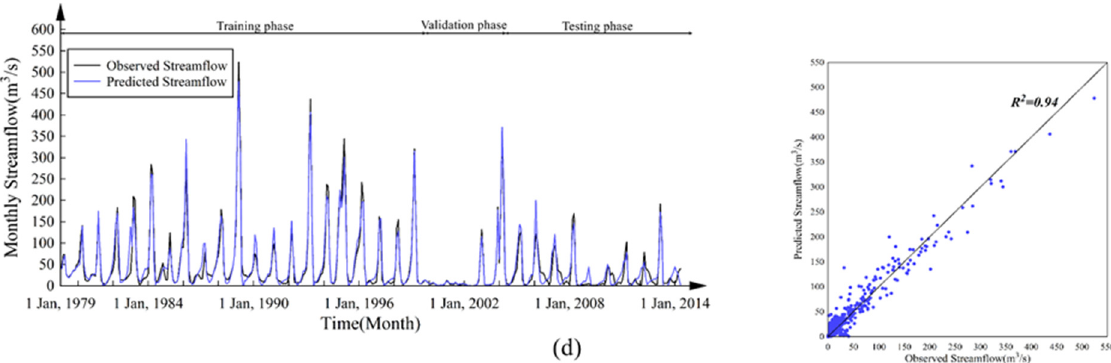
Figure 6. Comparison of observed and predicted streamflow for ( a ) Safakhaneh, ( b ) Boukan dam, ( c ) Qezkorpi, ( d ) Nezamabad stations.